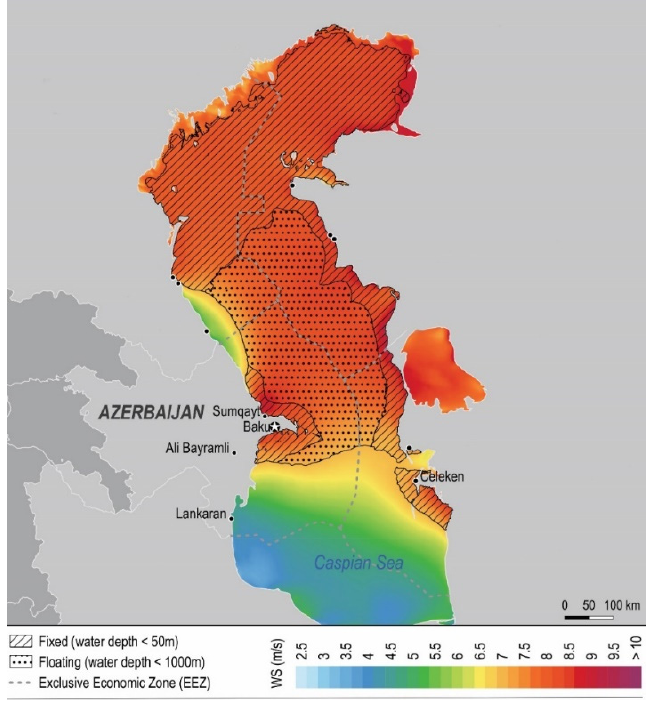
Figure 10. Wind atlas of the Caspian Sea [35].